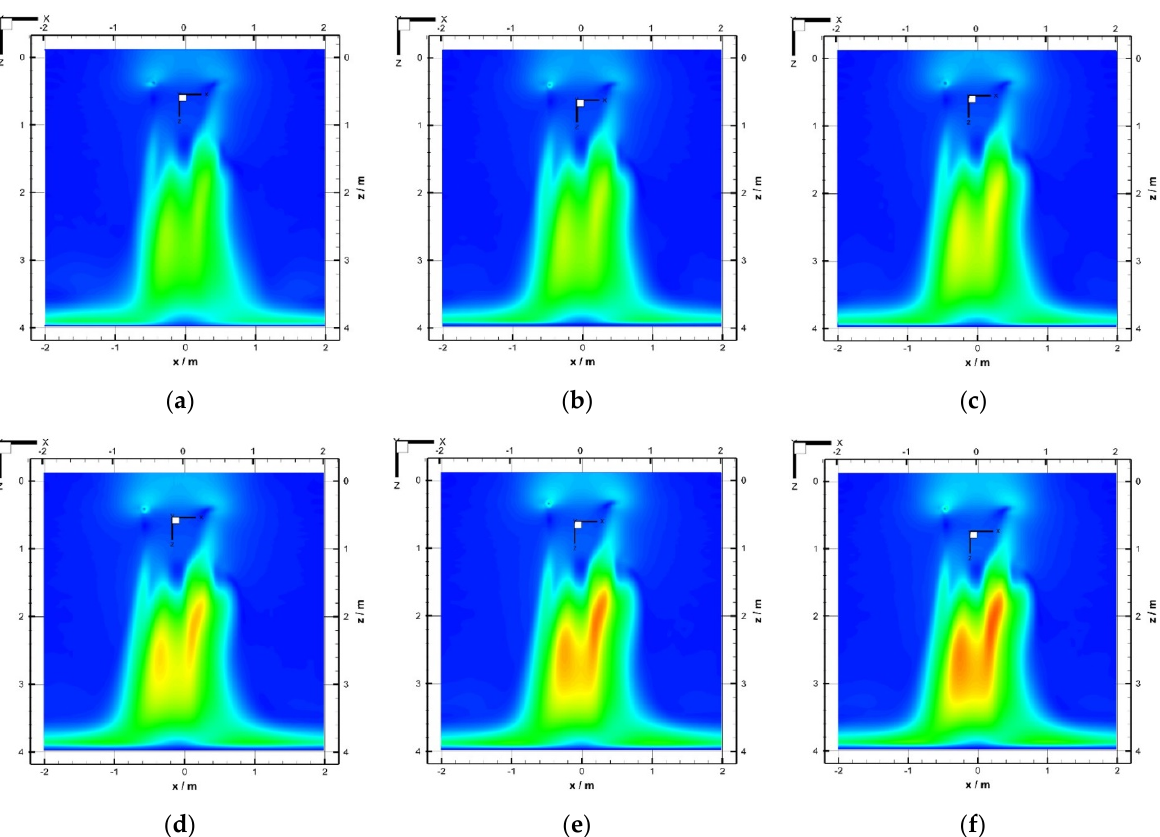
Figure 6. Velocity distribution of the ZOX planes of different pesticide load: ( a ) 0 kg; ( b ) 1 kg; ( c ) 2 kg; ( d ) 3 kg; ( e ) 4 kg; ( f ) 5 kg.